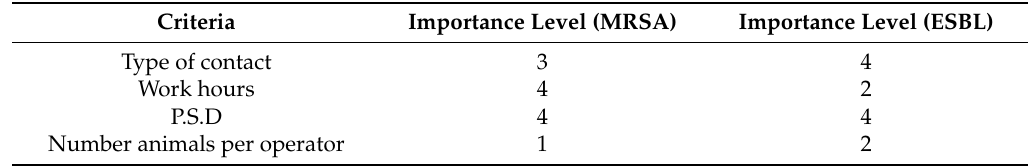
Table 8. Levels of importance to each of the